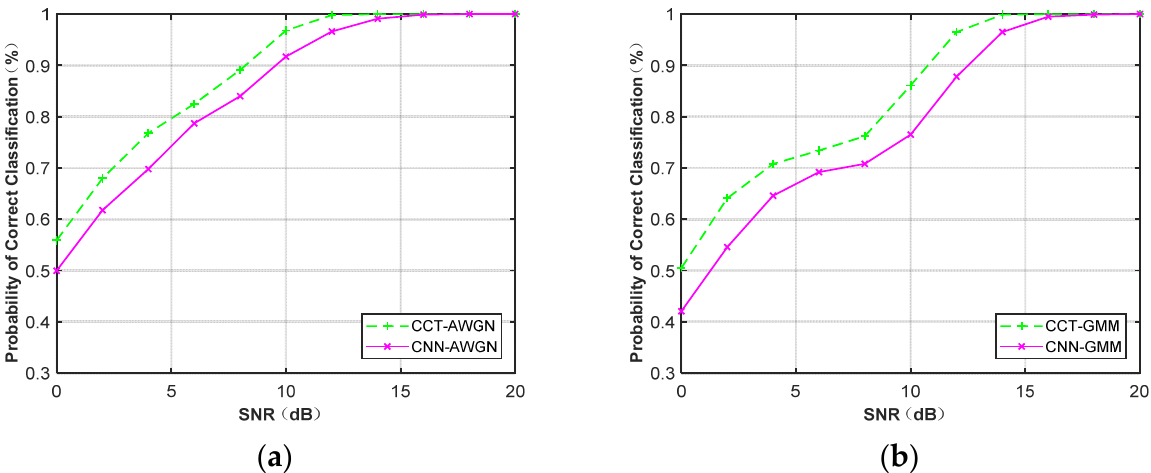
Figure 15. Performance comparison of MQAM based on the feature of raw IQ data (N = 512). ( a ) AWGN. ( b ) Non-Gaussian channel.